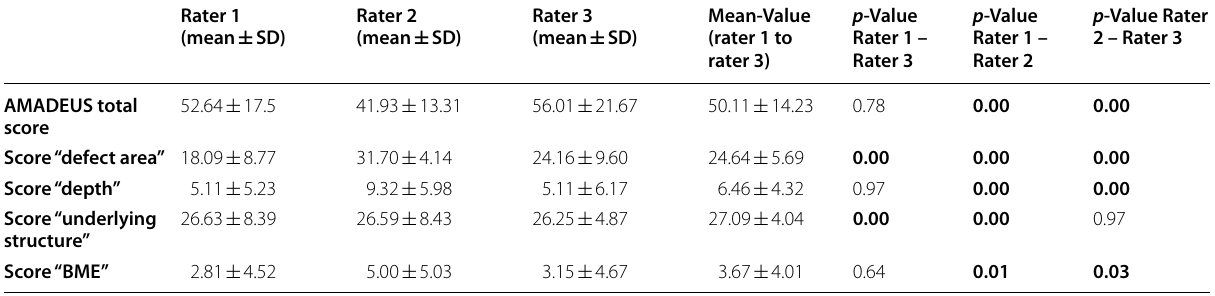
Table 5 Mean values of the AMADEUS subscores for each rater respectively. A Kruskal–Wallis-Test was performed to reveal significant differences in the mean values within an AMADEUS subscore for different